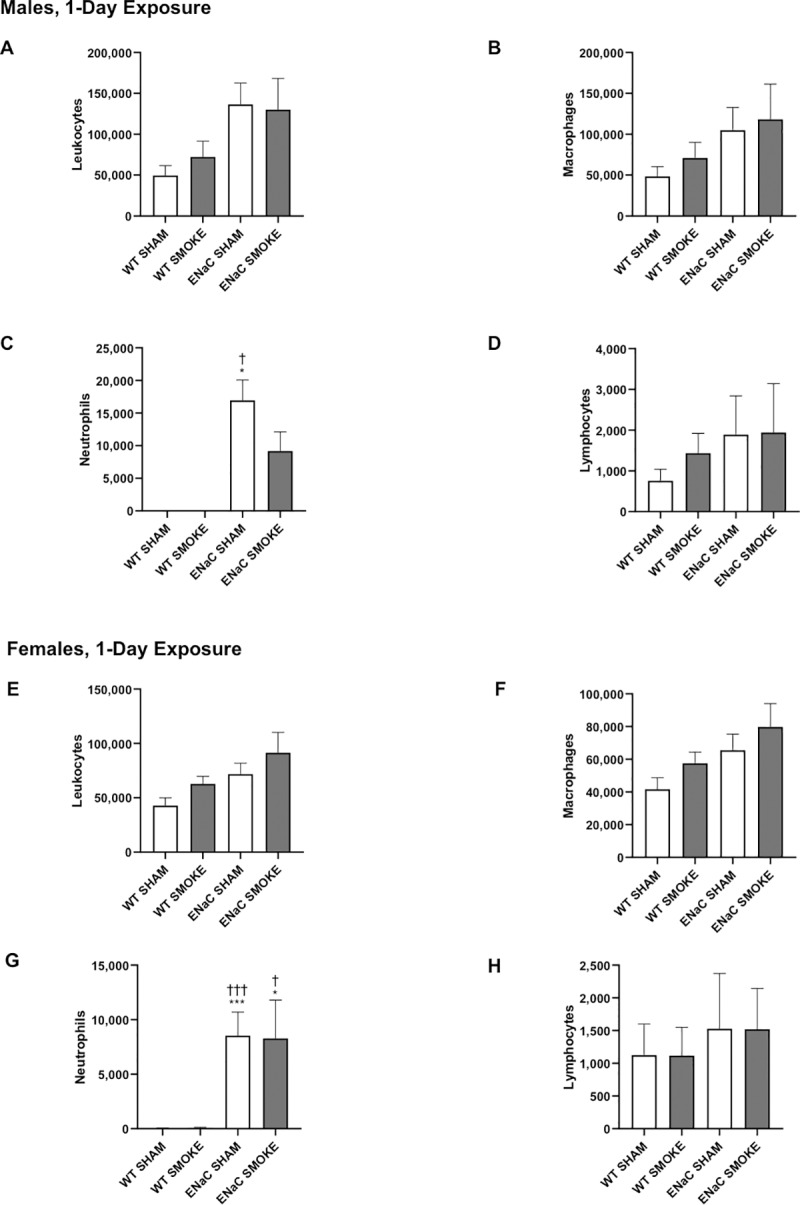
Effect of 1-day cigarette smoke exposure on BAL leukocyte numbers.The leukocyte counts in the BAL are described for males (A-D) and females (E-H) after 1-day sham or smoke exposure. A, E: leukocytes; B, F: macrophages; C, G: neutrophils; D, H: lymphocytes. Data are expressed as the total number of each leukocyte subtype in the BAL fluid. Analysis by ANOVA with Bonferroni’s post hoc test. Significance compared to (*) sham-exposed WT, (†) smoke-exposed WT, (‡) sham-exposed βENaC. Analysis by unpaired t-test: significance compared to (§) sham-exposed WT, (¶) smoke-exposed WT, (||) sham-exposed βENaC. Single symbols indicate p values < 0.05, double symbols indicate p values <0.01, and triple symbols indicate p values <0.001. Bars represent mean ± SEM.